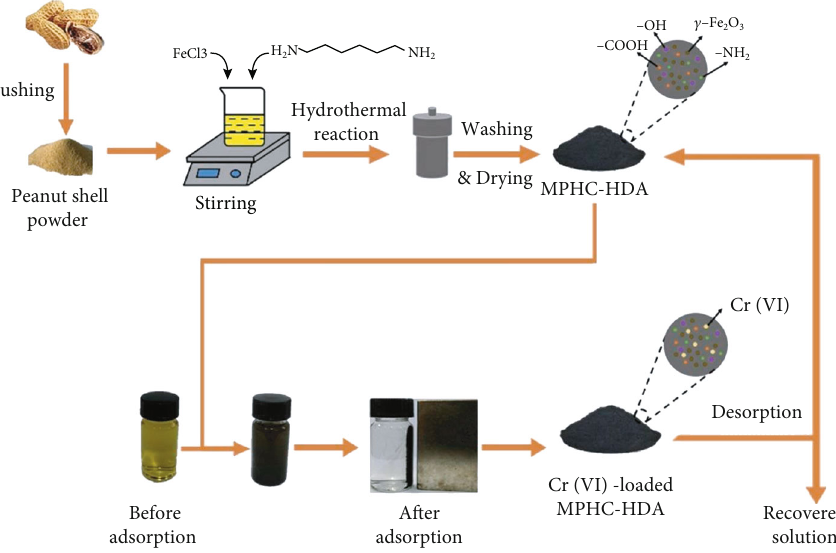
Figure 3: HTC used to prepare magnetic adsorbents for Cr (VI) removal from aqueous solution